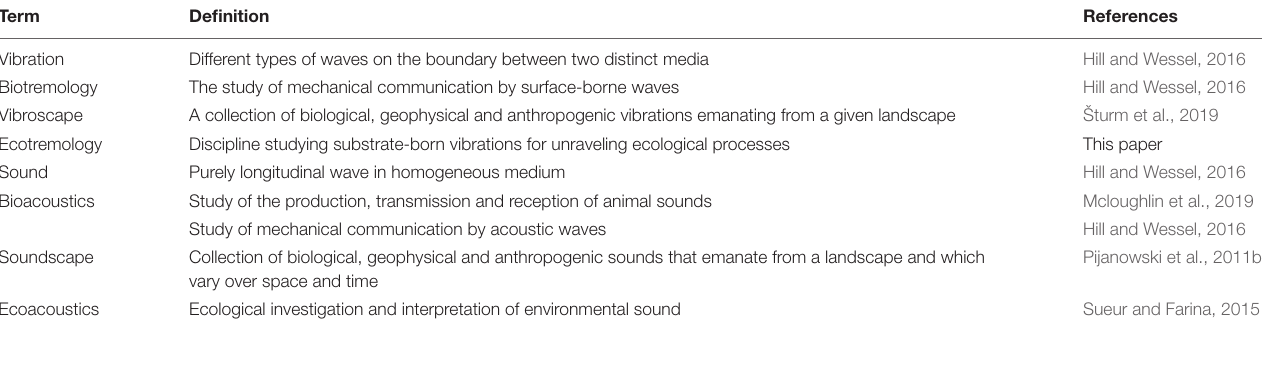
TABLE A1 | Table of relevant terms as used in the main text with their